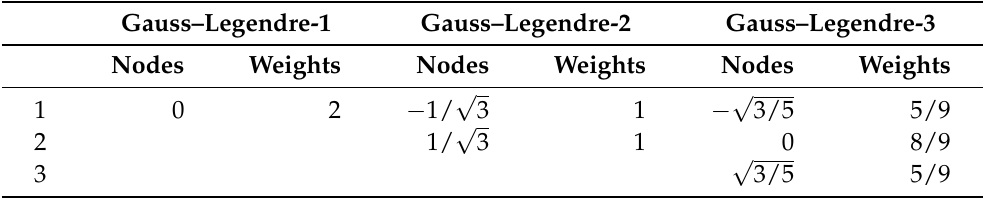
Table A2. Nodes and weights of the Gauss–Legendre quadrature formulas of order 1, 2, and 3 on the interval [ − 1,1 ]